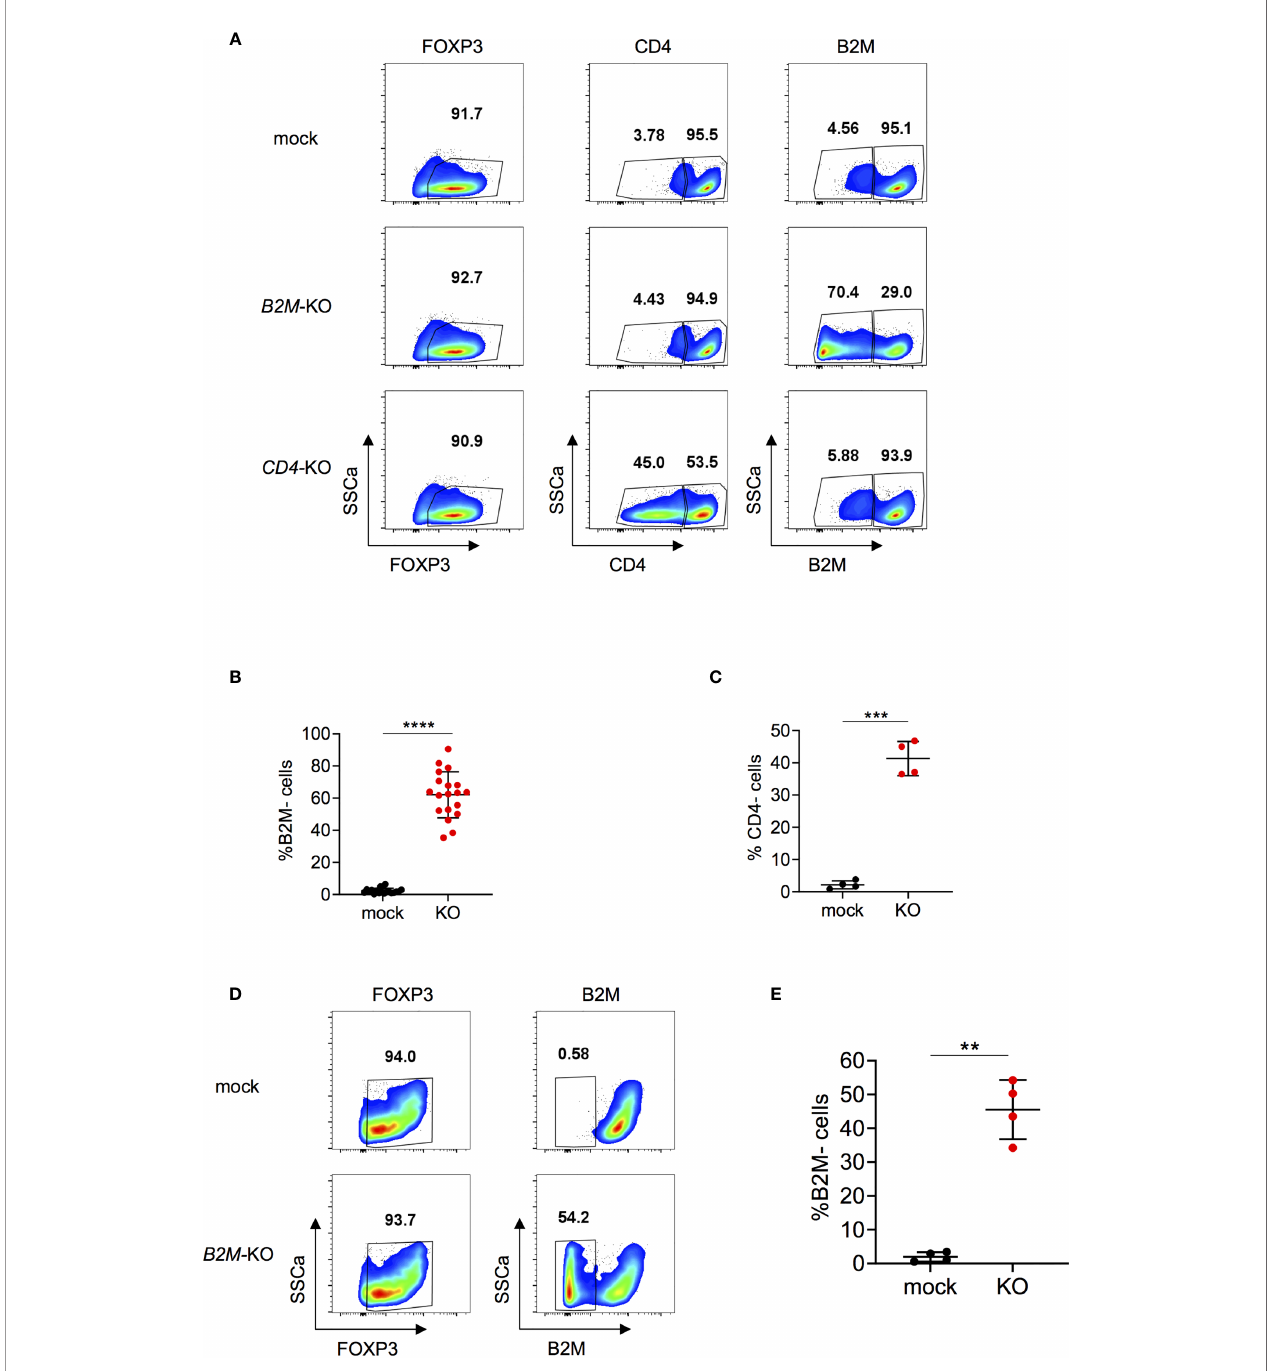
FIGURE 2 | B2M and CD4- KO in human Tregs. (A) Human Tregs were cultured for 7 days in vitro prior gene editing (following protocol described in Figure 1A ). FOXP3, CD4 and B2M expression were analyzed in mock, B2M -KO and CD4 -KO Tregs that were harvested 5 days after RNP nucleofection. FOXP3 plots are pre- gated on living cells. Plots showing CD4 and B2M expression are pre-gated on living FOXP3 + cells. Data are from one representative experiment. (B) B2M protein expression was studied in B2M-KO Tregs 3 to 7 days after nucleofection (n = 19 independent donors). Error bars represent mean ± SD. (C) CD4 protein expression was studied in CD4-KO Tregs 3 to 5 days after nucleofection (n = 4 independent donors). Error bars represent mean ± SD. (D, E) Tregs were stimulated for 24 hours prior gene editing. FOXP3 and B2M expression were analyzed in mock or B2M -KO Tregs 4 days after RNP nucleofection. Plots showing FOXP3 expression are pre-gated on living cells. B2M plots are pre-gated on living FOXP3 + cells. Data are from one representative experiment (D) and 4 independent donors (E) . Error bars represent mean ± SD. Signi fi cance was calculated using two-tailed paired Wilcoxon test (B) or by a two-tailed paired t test (C,E). **p ≤ 0.01, ***p ≤ 0. 001, ****p ≤